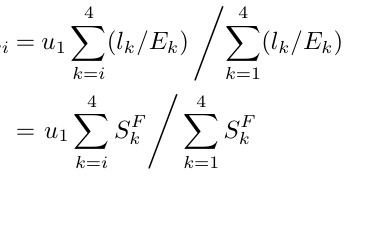
◦ Fig. 5. Output of PVDF1 ( I 1 ) versus that of PVDF2 ( I 2 ) on plastic foams of 10 mm ( rubbers of 10 mm ( ), 20 mm ( (cid:3) ) and 25 mm ( ♦ )